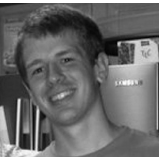
bottom). (C) The dependence of the pooled correlation, r , on population size, n , XY for the examples in (A,B) . Green line corresponds to population model (A) with r = 0.05 and r = 0.1, while the blue line corresponds to (B) with r = 0.05 and b w p = q = 0 (solid line); p = 0 and q = 1 (dashed line); p = 0.25 and q = 0 (dotted line). A moderate amount of overlap between the populations or independent inputs do not significantly affect the pooled correlation when n is large. The pink line corresponds to model (A) with r = r = 0.005. (D) The cross-correlation function b w from the population model in (A) with R ( t ) = R ( t ) = 0.05e − | t |/5 (1 + | t |/5) and for b w various values of n . The case n = 500 corresponds to the traces in (A) and the filled circles are from